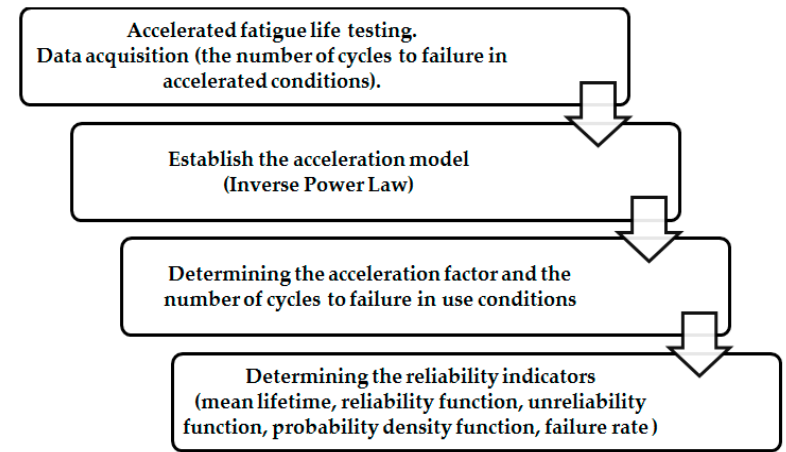
Figure 6. The statistical processing algorithm of the GFRP-foam specimens.